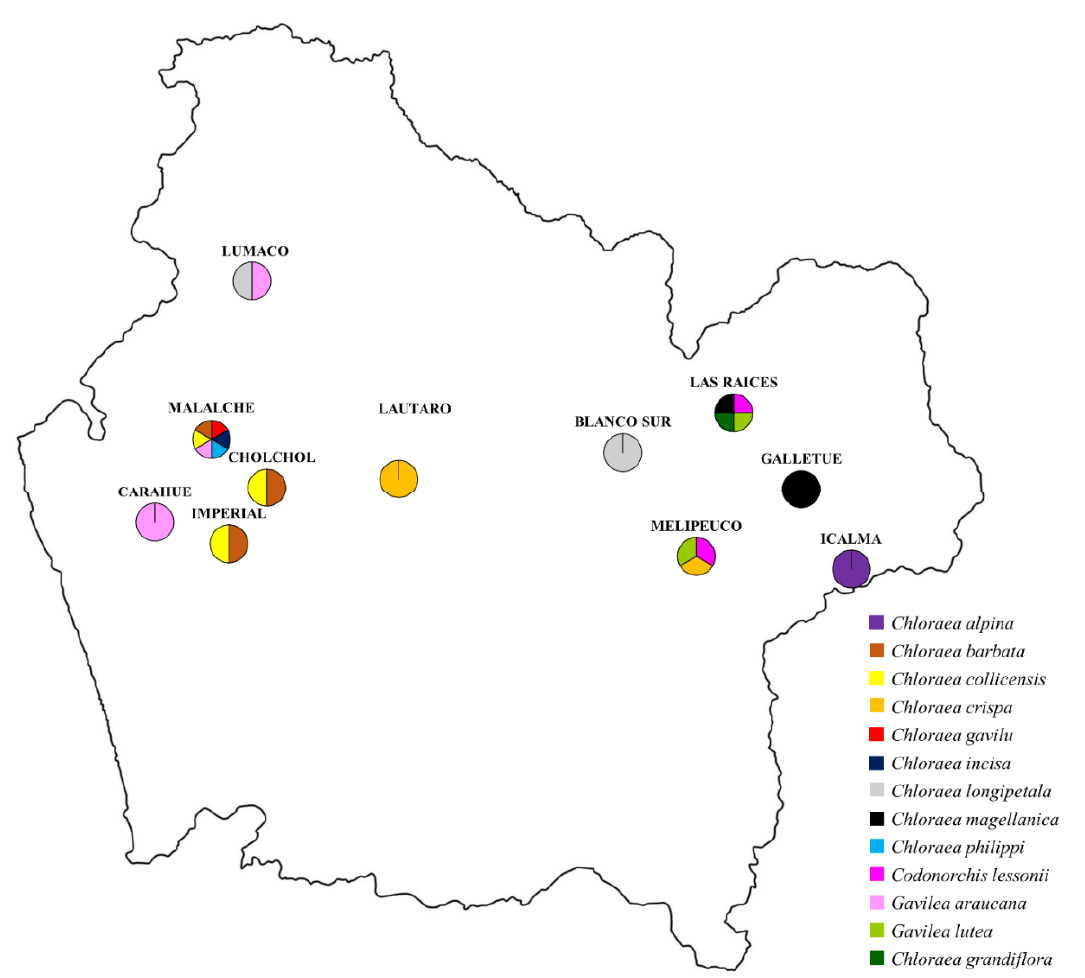
Figure 1. Sampling sites and presence of the analyzed orchid plants in Araucanía Region in southern Chile. Table 3. Molecular identification of culturable mycorrhizal fungi isolated from peloton-containing roots, based on the closest match in the GenBank database.